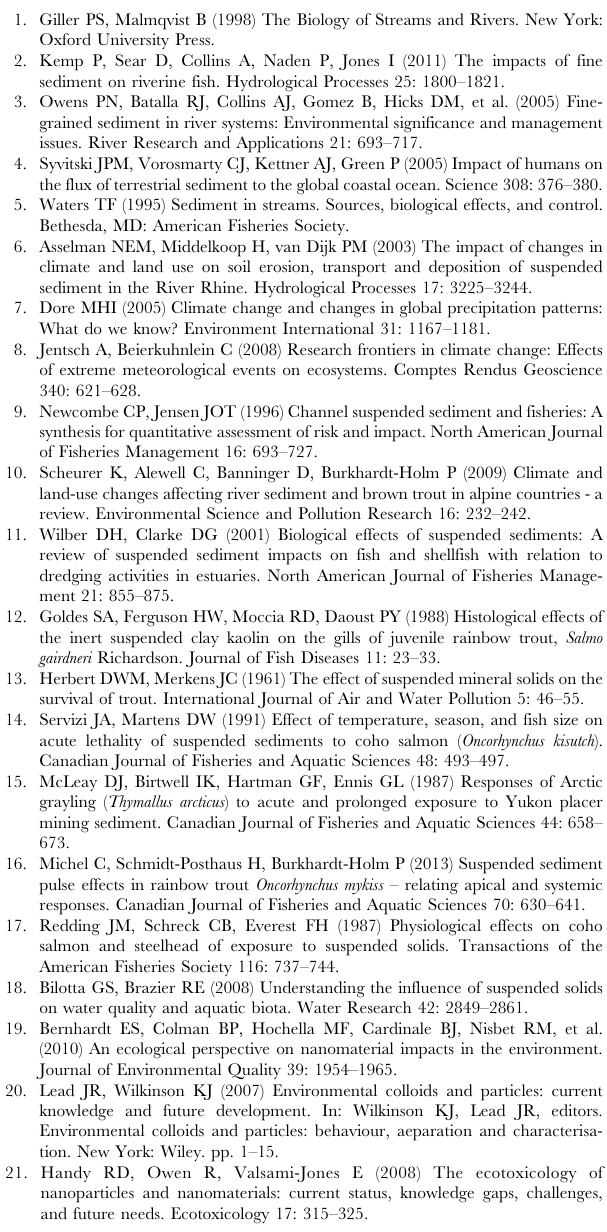
the plates. Table S1 Fold change intervals for relative cytotoxicity ranking given in Table